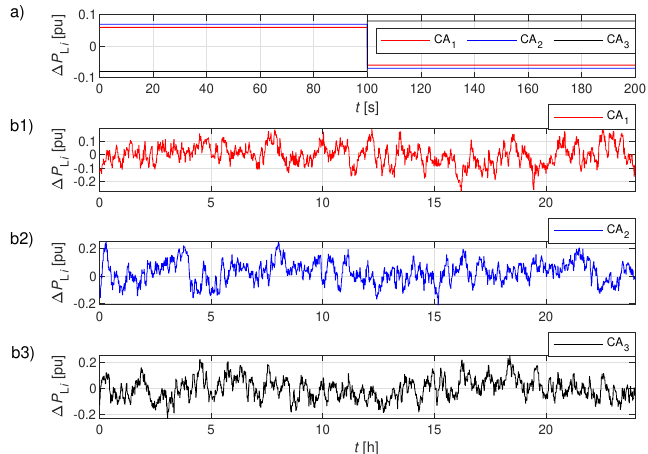
Figure 10. Step changes of ∆ P L i ( a ) and random ∆ P L i variations ( b1 – b3 ) for a three CA test